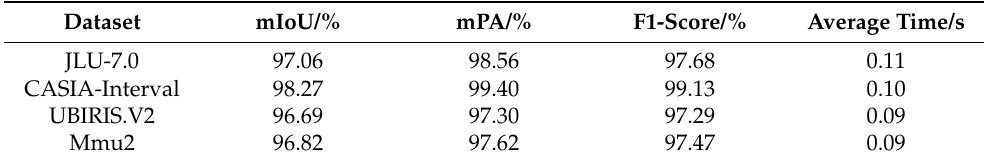
Figure 11. The cross-dataset segmentation results of PFSegIris on the JLU-7.0, CASIA-Iris-Interval-v4, UBIRIS.V2, and Mmu2 iris datasets, respectively: ( a ) original images; ( b ) ground truth; ( c ) segmentation results; ( d ) merged images. Table 4. The cross-dataset evaluation indexes of PFSegIris on the JLU-7.0, CASIA-Iris-Interval-v4, UBIRIS.V2, and Mmu2 iris datasets,